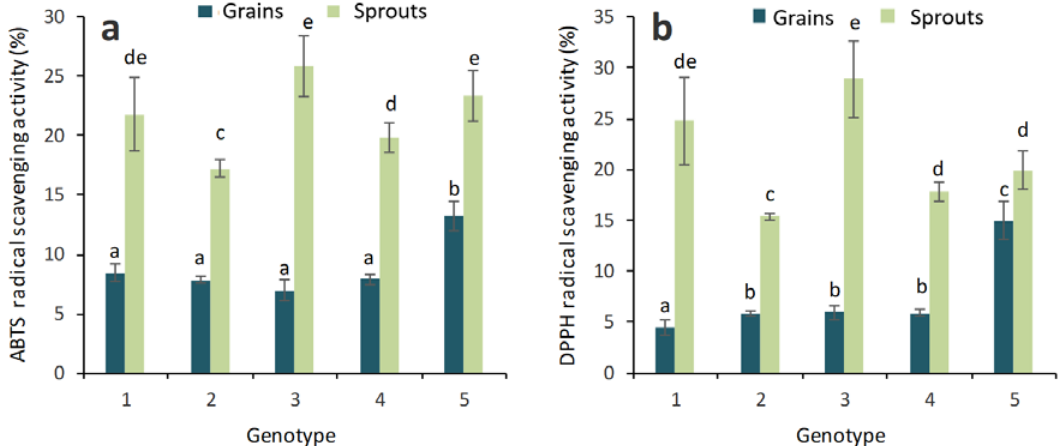
Figure 1. Antioxidant activity (ABTS test) ( a ) and (DPPH test) ( b ) in the grains and sprouts of colored wheat genotypes. 1—Citrus yellow, 2—KM 53-14 Blue, 3—KM 178-14 purple, 4—Skorpion Blue aleurone, 5—PS Karkulka purple. The columns represent the mean values ± S.E. for five replicates. Statistically significant differences among treatments at each time are indicated by different lowercase letters (Duncan test; p < 0.05).